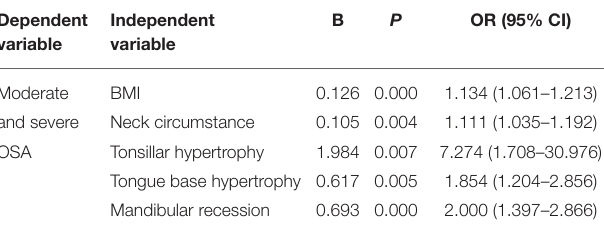
TABLE 2 | Association between the characteristics of the upper airway structure and severity of OSA in the regression